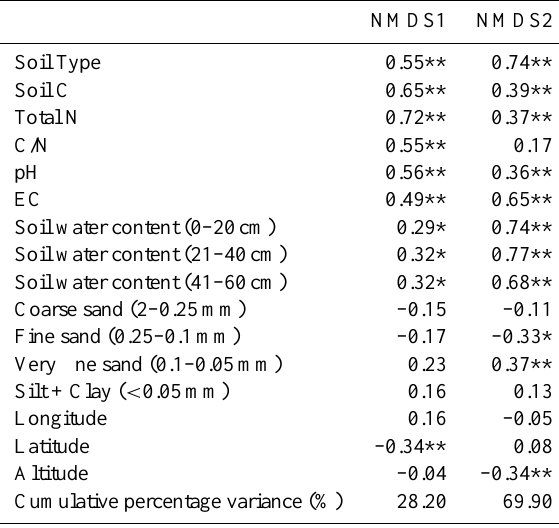
Table A1. Intra-set correlations of the environmental variables and cumulative percentage variance for the first two axes of NMDS in sandy grasslands.